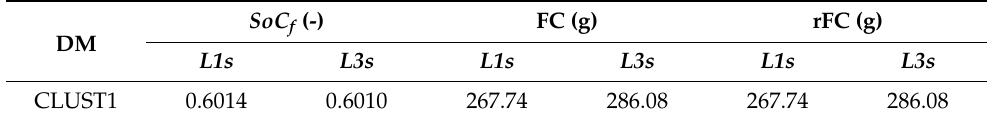
Table 8. Results by L1s and L3s exploration strategies on